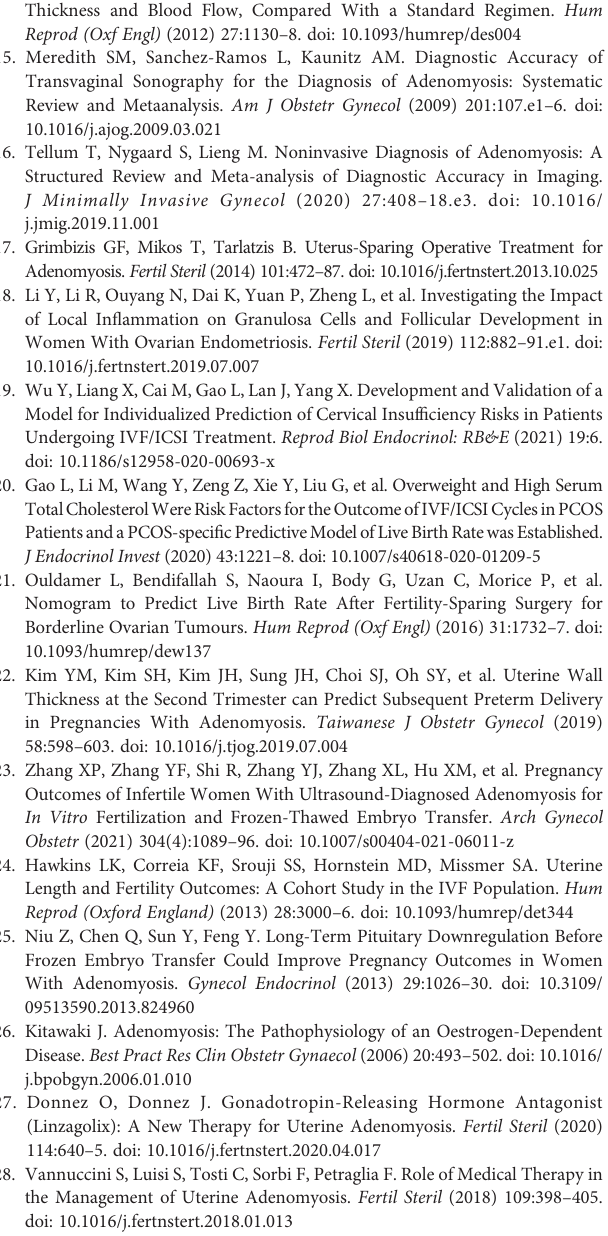
Supplementary Table 1 | Univariate and multivariate analyses of factors predicting the live birth in patients with adenomyosis undergoing frozen – thawed embryo transfer. BMI,body massindex; AMH, anti-Mullerian hormone; HRT, in vitro fertilization/intracytoplasmic sperm injection; NC, nature cycle, FET, frozen – thawed embryo transfer. * P < 0.05 was considered statistically signi fi